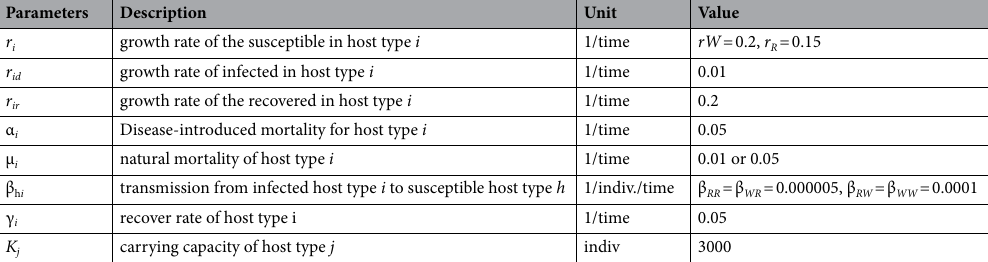
Table 1. All parameter notation, description, unit in the model and values for simulation. i = W or R, representing host genotype wild-type and robust type,